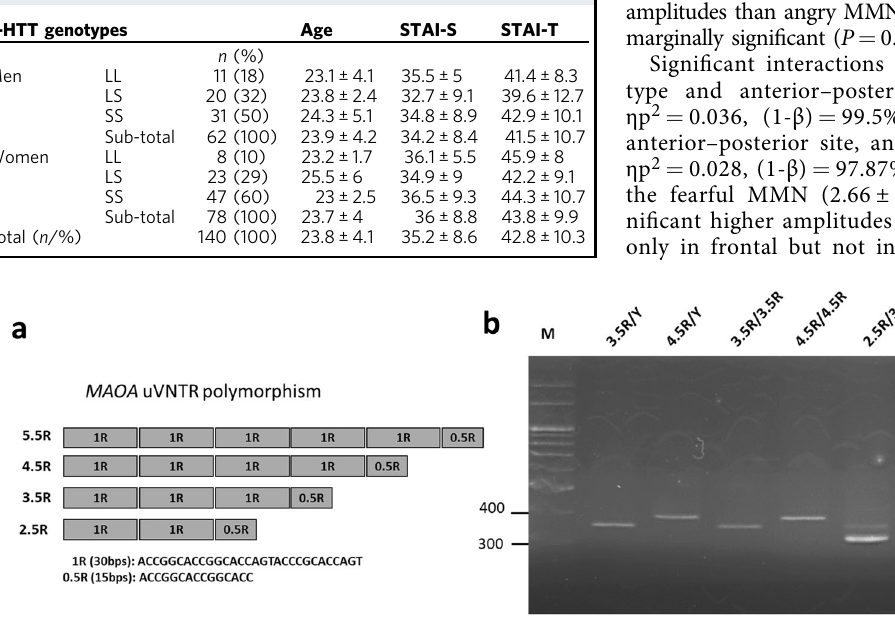
Table 1 Demographic and descriptive statistics of 5-HTT genotypes in the Taiwanese population (mean ± SD).